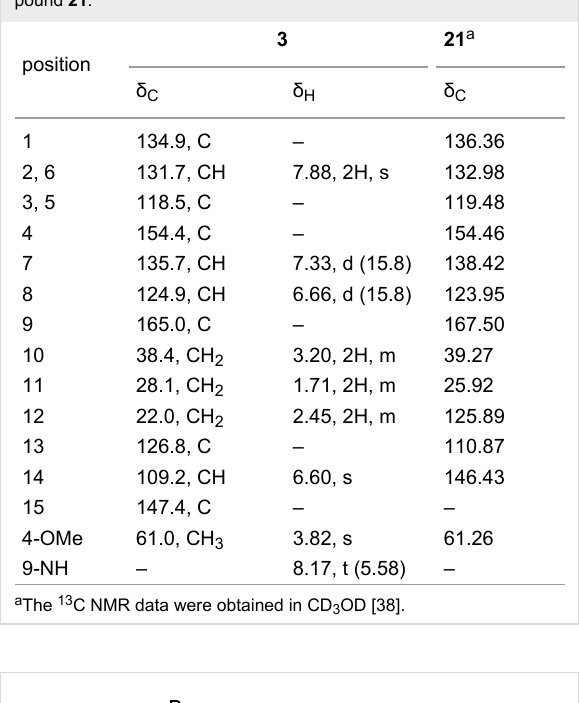
Table 4: NMR data of aplysinin B ( 3 ) (600 MHz, DMSO- d 6 ) and com- pound 21 .